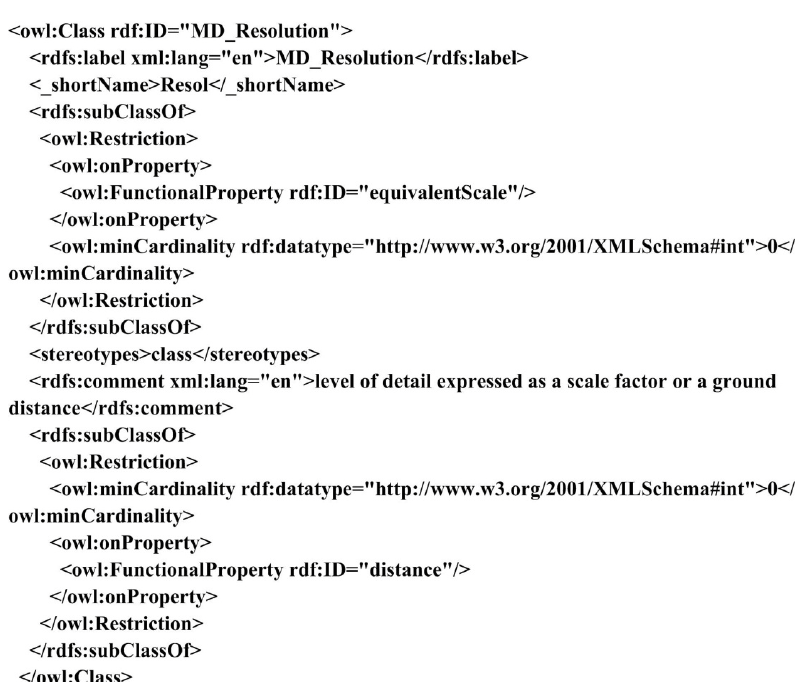
Figure 7. Code segments describing a relationship of “subClassOf” from the ISO 19115 meta-data standard using